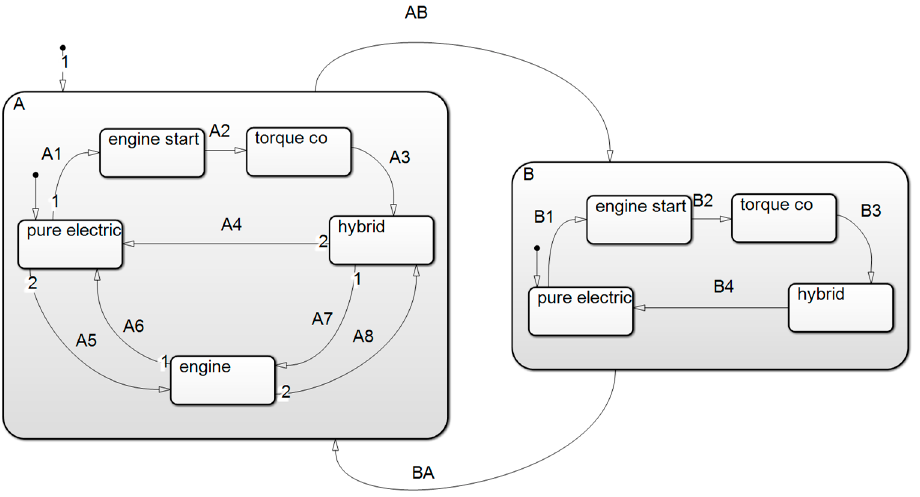
Figure 4. The state switching of the rule-based control strategy of the HEV with torque coordination.